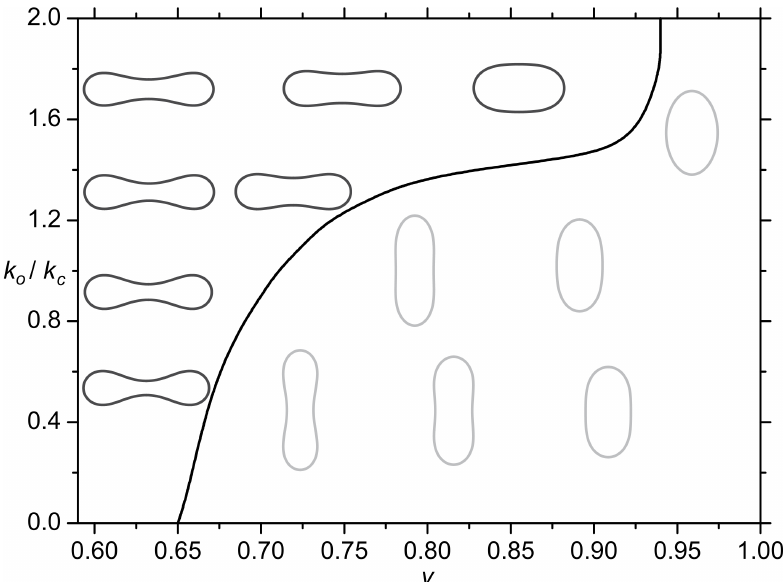
Figure 11. Phase diagram of equilibrium closed membrane shapes with nematic in-plane ordering taken into account. The solid line separates the stability regimes between discocyte (oblate) and prolate shapes. Discocyte shapes are stable on the left side and prolate shapes on the right side of the line. The energy associated with nematic ordering is weighted by the constant k o against the isotropic bending energy weighted by the membrane bending constant k c (Equation (15)). Adapted with permission from ref. [137]. 2019 Springer